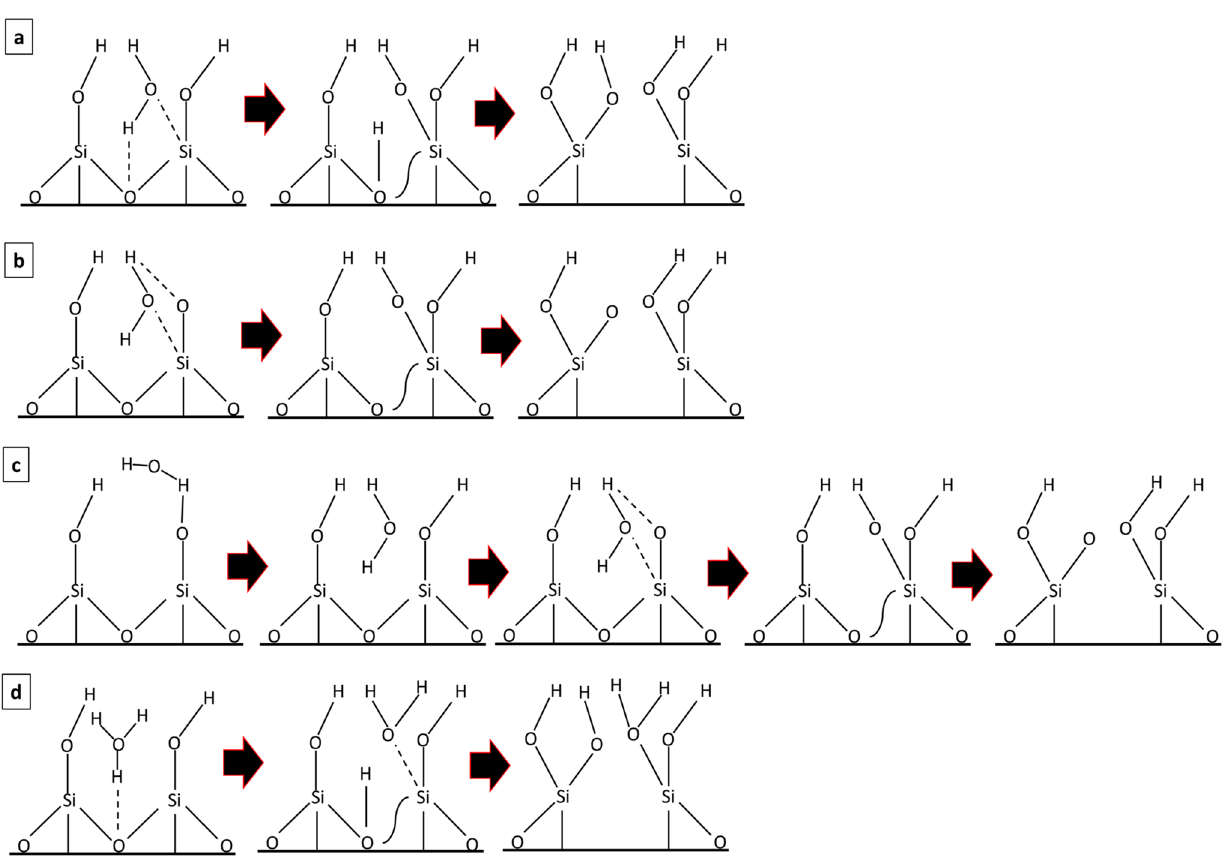
Fig. 1 Graphical representation of four possible hydrolysis mechanisms of quartz dissolution (Bickmore et al. 2008; Pelmenschikov et al. 2000; Xiao and Lasaga